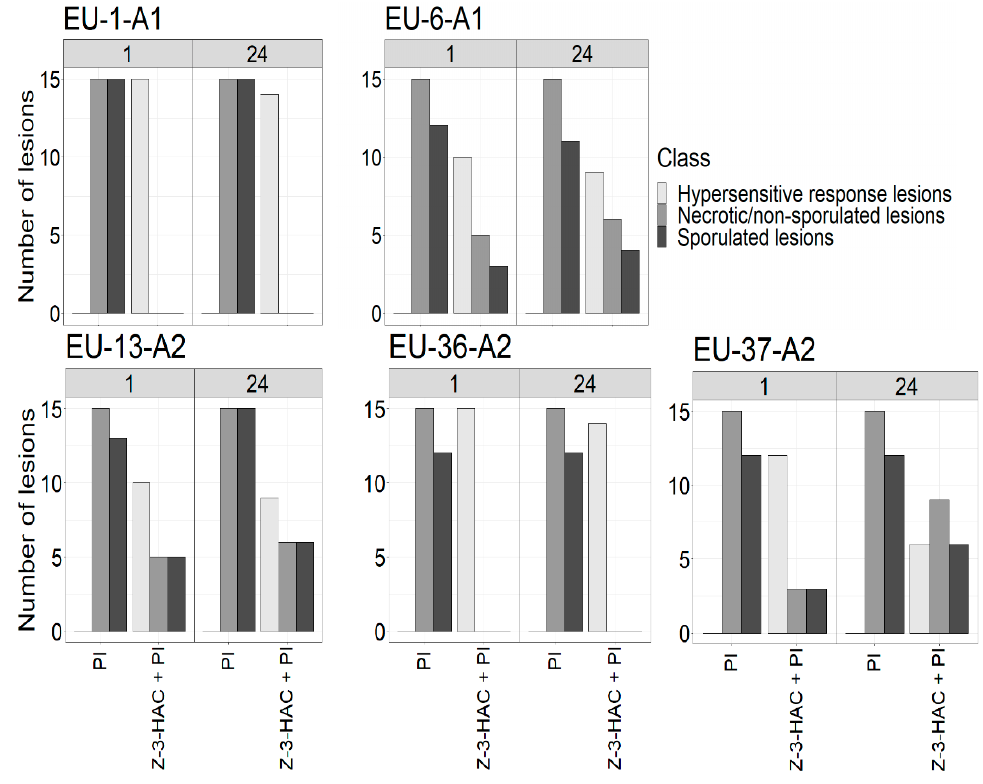
Figure 3. Number of lesions belonging to the different symptom classes (hypersensitive response, necrotic/non-sporulated lesions and sporulated lesions) on unexposed potato leaves inoculated with various P. infestans genotypes (EU-1-A1, EU-6-A1, EU-13-A2, EU-36-A2, EU-37-A2) (PI) and on potato leaves pre-exposed to the Z-3-HAC and subsequent infection with P. infestans genotypes (Z-3-HAC + PI) at 1 and 24 h postexposure. The class distribution between treated and untreated leaves was significantly different according to the chi-square test ( p -value < 0.01). All measurements were assessed seven days after infection.